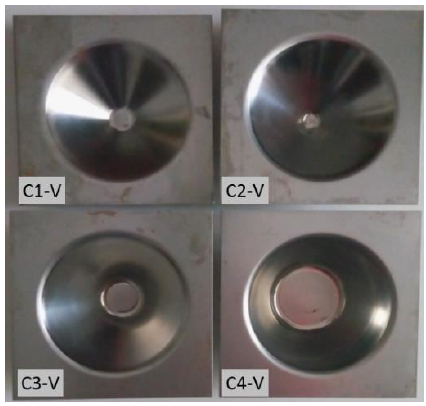
Figure 18. Machined parts used in the validating process of the mathematical models, reprinted with permission from ref. [5].